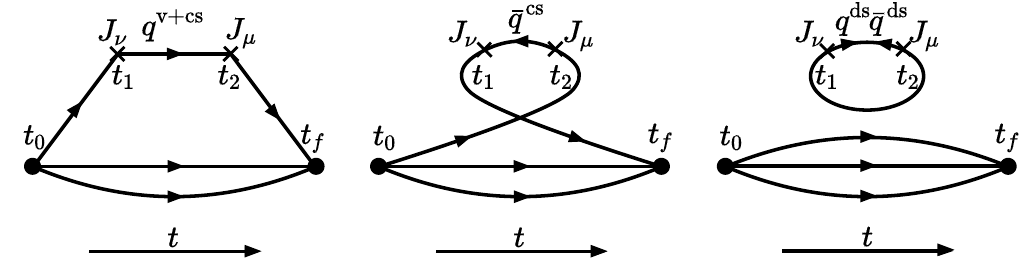
Figure 1: Three gauge invariant and topologically distinct insertions in the Euclidean- path integral formulation of the nucleon hadronic tensor where the currents couple to the same quark propagator. In the DIS region, the parton degrees of freedom are as follow. The left panel: the valence and connected sea (CS) partons q v + cs ; the middle panel: the CS anti-partons ¯ q cs ; the right panel: the disconnected sea (DS) partons q ds and anti-partons ¯ q ds with q = u , d , s , and c . Only u and d are present in the left and middle panels for the nucleon hadronic